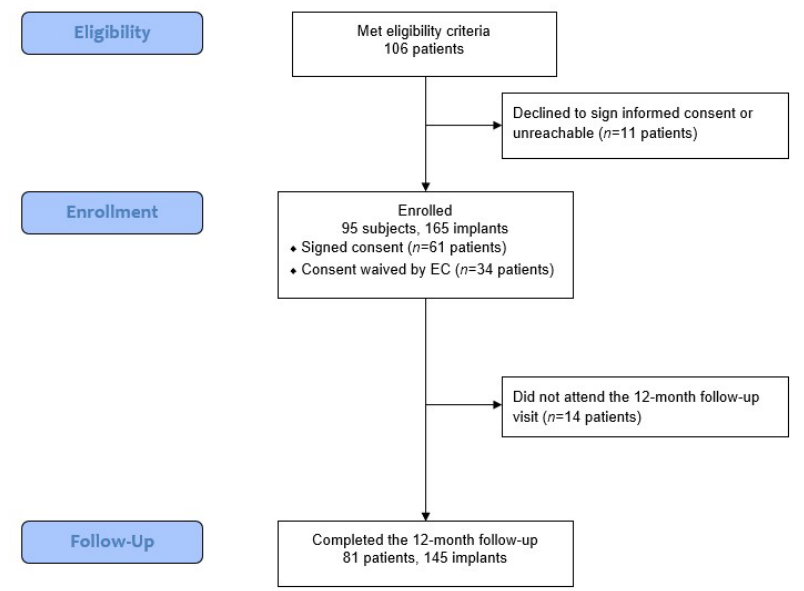
Figure 2. Data collection flow. EC, ethical committee.